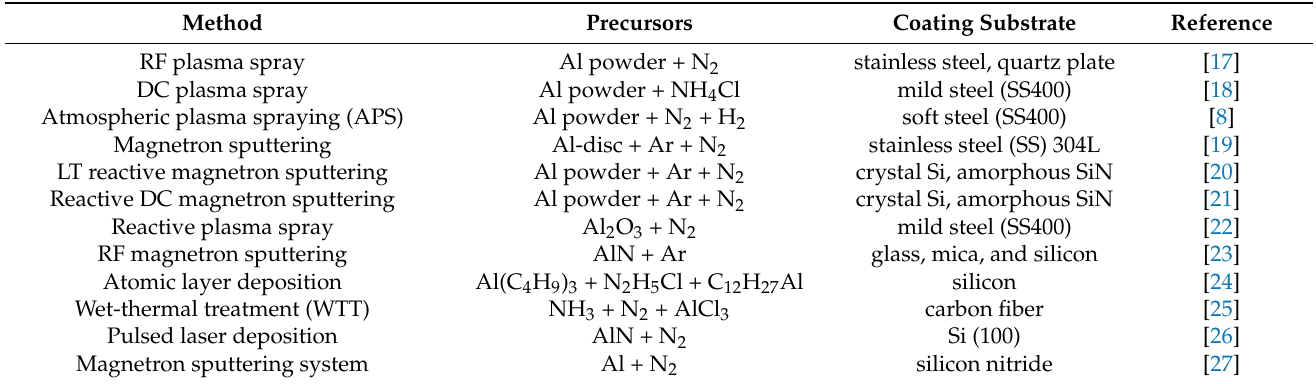
Table 2. Summary of different methods used in producing AlN coatings.